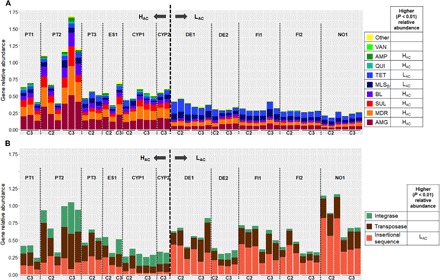
Relative gene abundance observed in influent samples from HAC and LAC countries.Relative abundance of (A) resistance genes and (B) mobile genetic elements. The data refer to the sum of relative abundance of amplification (ratio ARG or MGE copy number: 16S rRNA gene copy) for a given pair of primers, organized in classes of “resistance” or “transfer and recombination.” In the legend, for each gene class, the country group, HAC or LAC, with significantly higher relative abundance (P < 0.01, Mann-Whitney U test) is indicated. Samples are organized according to the sampling campaign (C2, spring 2016; C3, autumn 2016), divided by HAC and LAC. Resistance categories: AMG (aminoglycosides), MDR (multidrug resistance), SUL (sulfonamides), BL (β-lactams), MLSB, TET (tetracycline), QUI (quinolones), AMP (amphenicols), VAN (vancomycin), and others. Note: Ireland data are missing because of restrictions on influent wastewater sample collection.